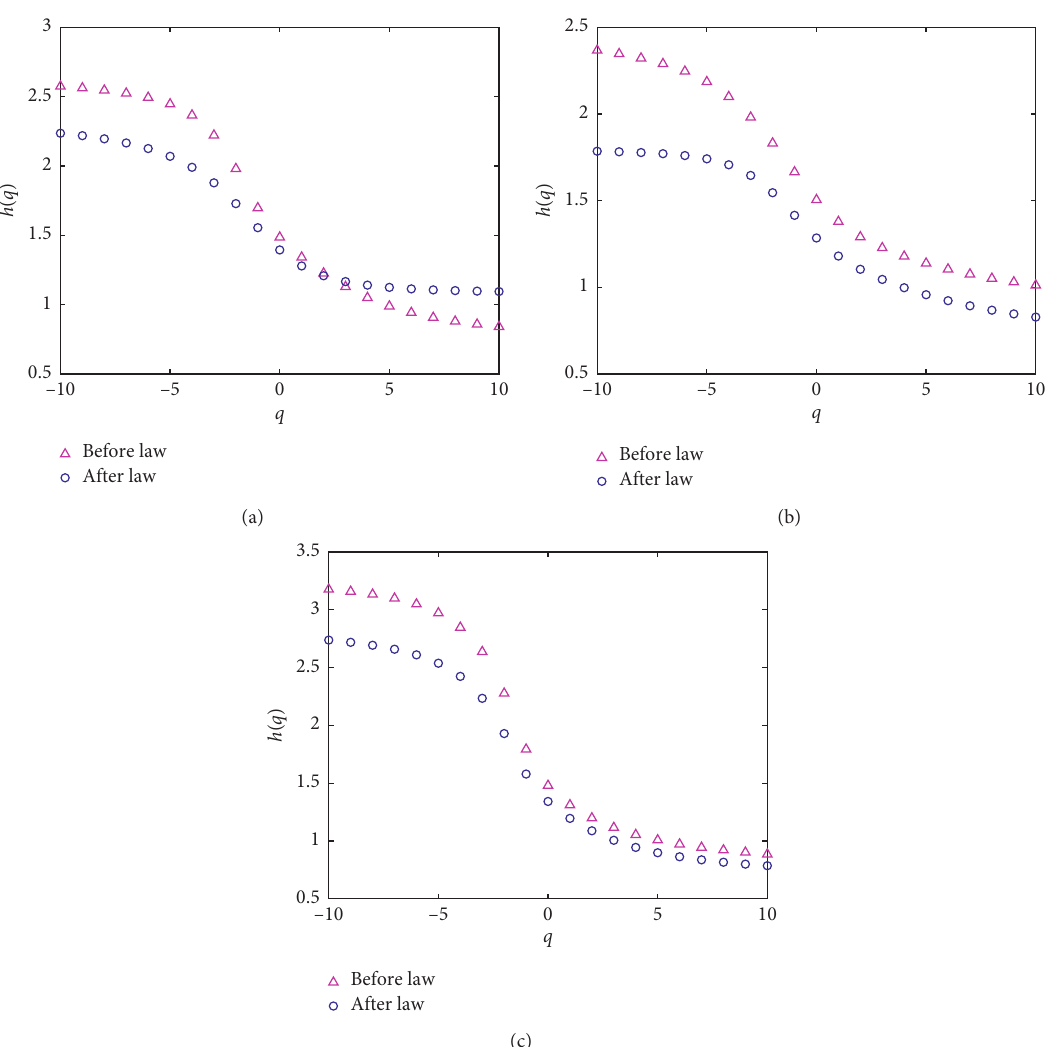
Figure 9: Hurst exponent of PM